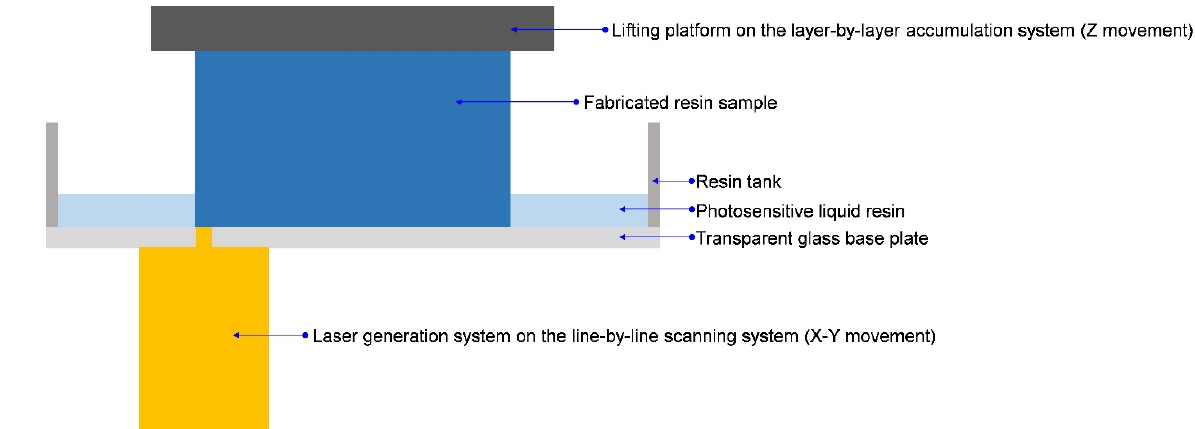
Figure 2. Schematic diagram of the fabrication process in the SLA.